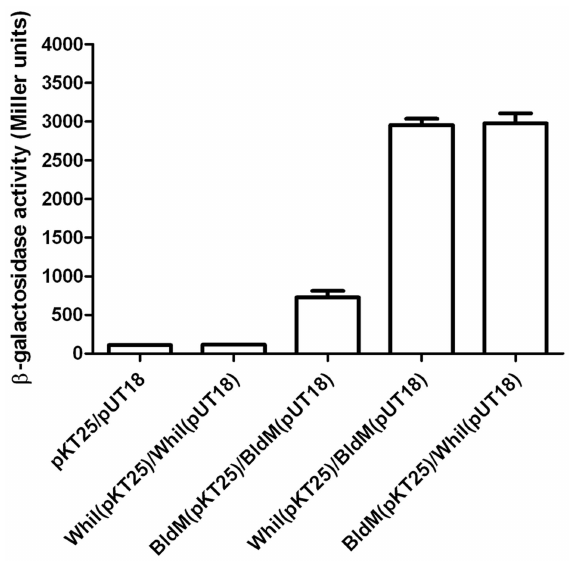
Figure 4. Bacterial two-hybrid analysis of BldM-WhiI interac- tion. The listed pairs of constructs were transferred into the BACTH reporter strain E. coli BTH101 by transformation. The resulting transformants were selected on MacConkey-maltose agar containing 100 m g/ml carbenicillin and 50 m g/ml kanamycin and incubated at 30 u C for two days before four independent clones were picked and subjected to b -galactosidase assays. Error bars show the standard error of the four replicates carried out for each pairwise